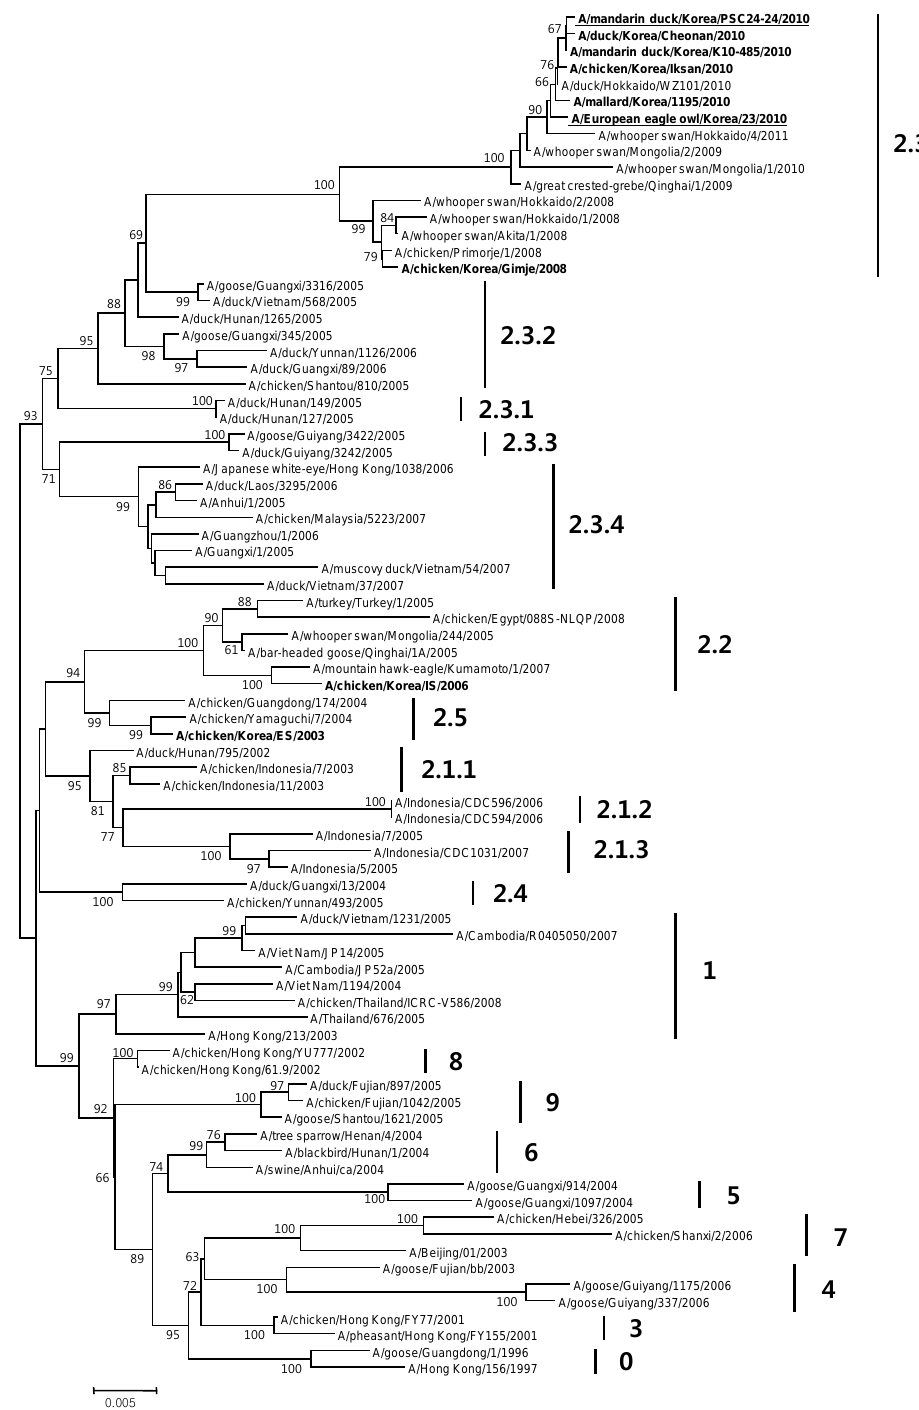
Figure 1. Phylogenetic analysis of the ( A ) hemagglutinin (HA) and ( B ) acidic polymerase (PA) genes. The Korean H5N1 HPAI viruses are indicated in bold, and the two isolates analyzed in this study are underlined. The genotypes (clade) of the viruses are indicated with vertical lines. The sequences were multiply aligned, and the phylogenetic tree was constructed with the neighbor-joining method (bootstrap value of 1000) using MEGA5 software. The scale bar indicates the average number of nucleotide substitutions per